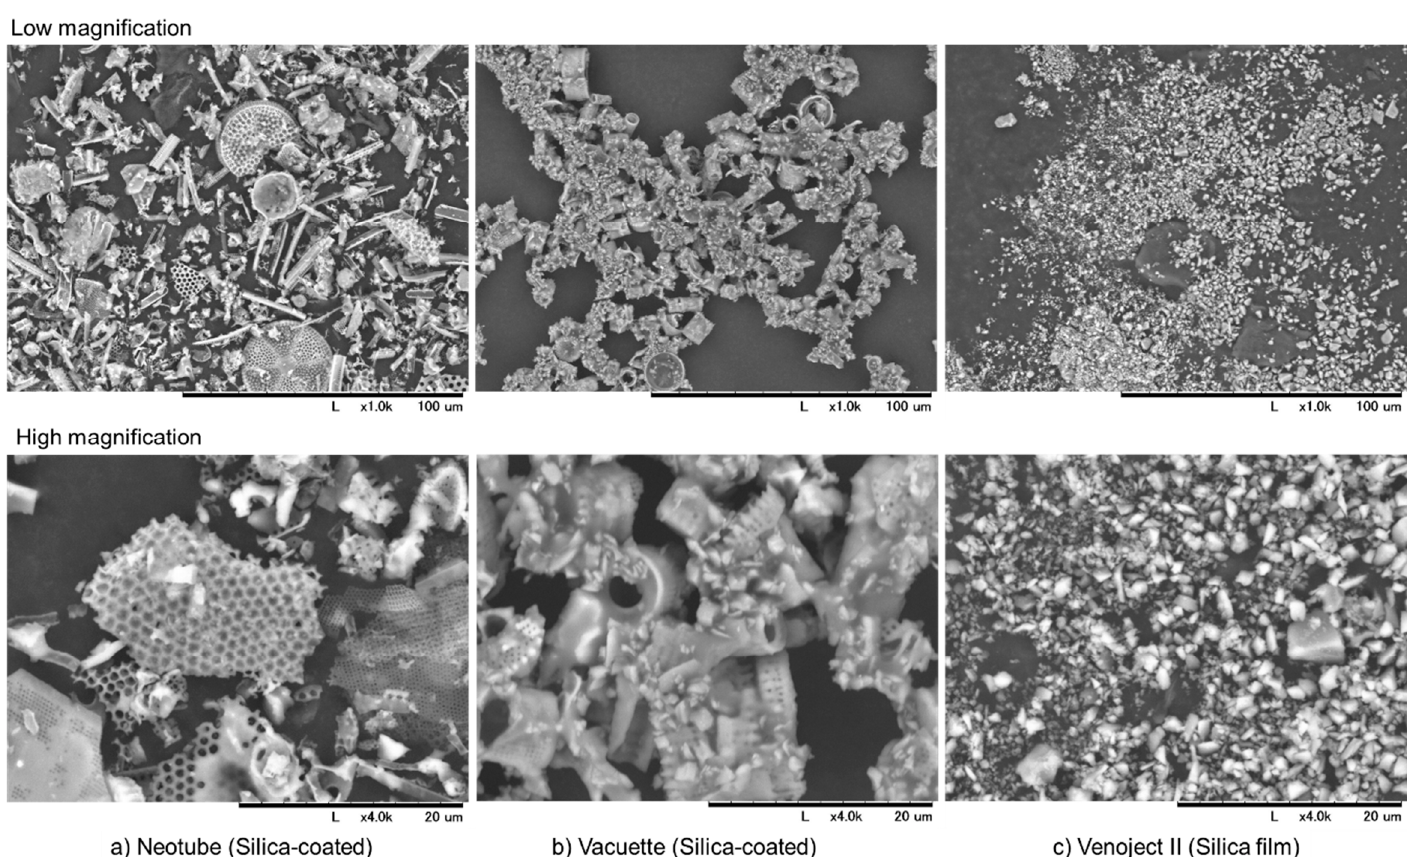
Figure 2. Scanning electron microscopy (SEM) observations of silica microparticles contained in ( a ) Neotube tubes ( b ) Vacuette tubes and ( c ) Venoject II tubes at low ( Upper ) and high magnification ( Lower ).